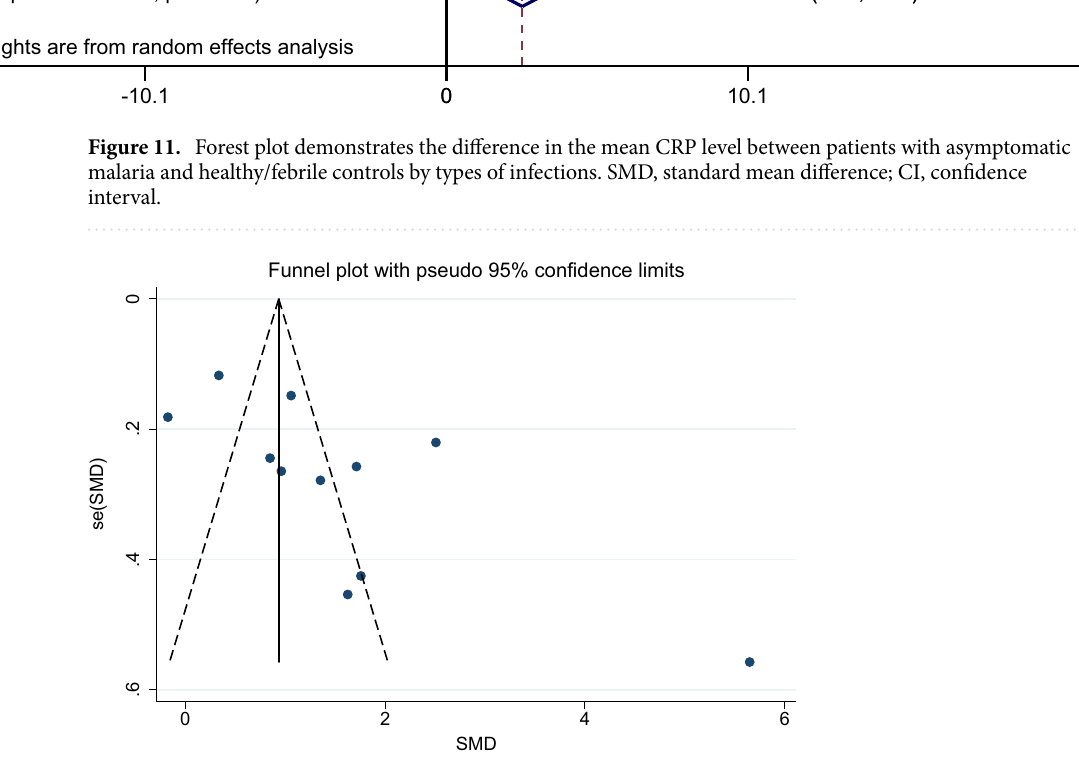
Figure 12. Funnel plot demonstrates the publication bias among 11 studies comparing the mean CRP level between patients with severe and uncomplicated malaria. SMD, standard mean difference; se, standard